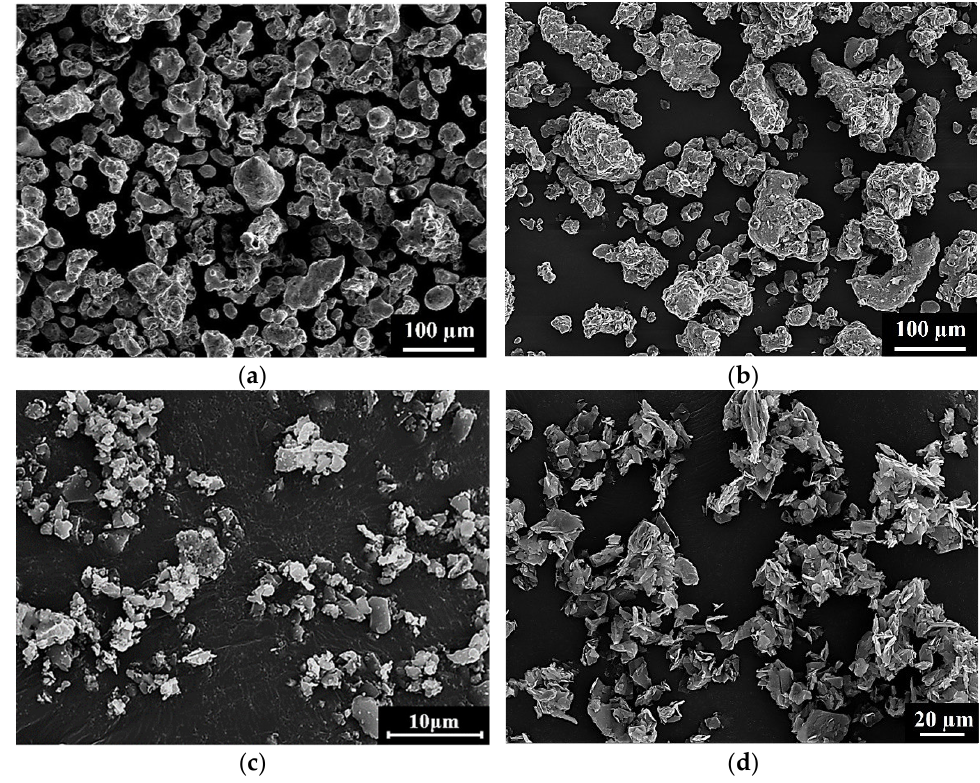
Figure 1. The morphologies of the raw powders used in this study. ( a ) 304L ( b ) 410L ( c ) B ( d ) graphite.